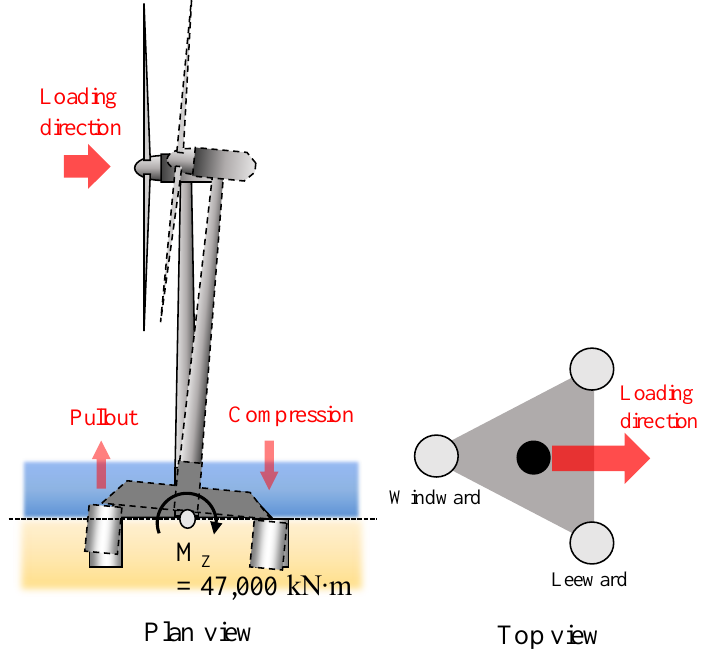
Figure 6. Direction of loading during testing.